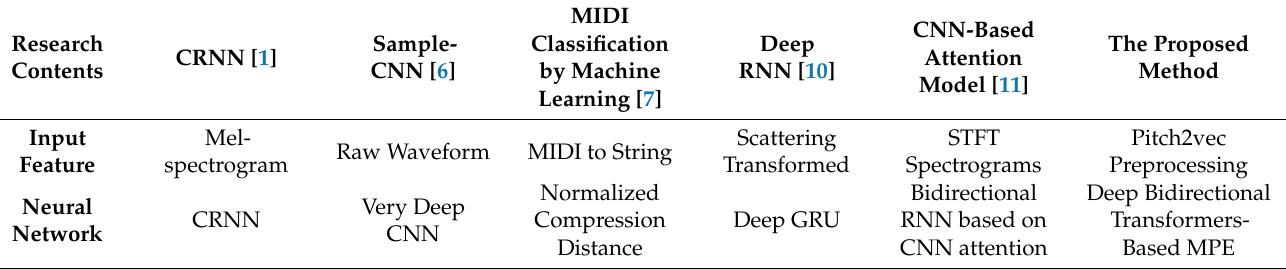
Table 1. Difference between previous research and the proposed